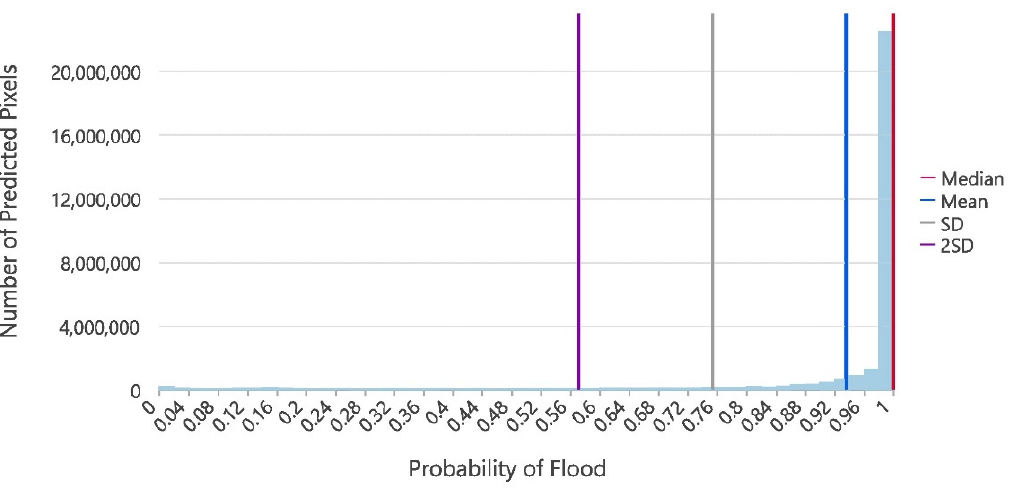
Figure 6. Distribution of the predicted flood probability (derived from the multi-sites training random forest classification model) within the existing flood hazard areas (FDRP and RVCA maps, used for training).